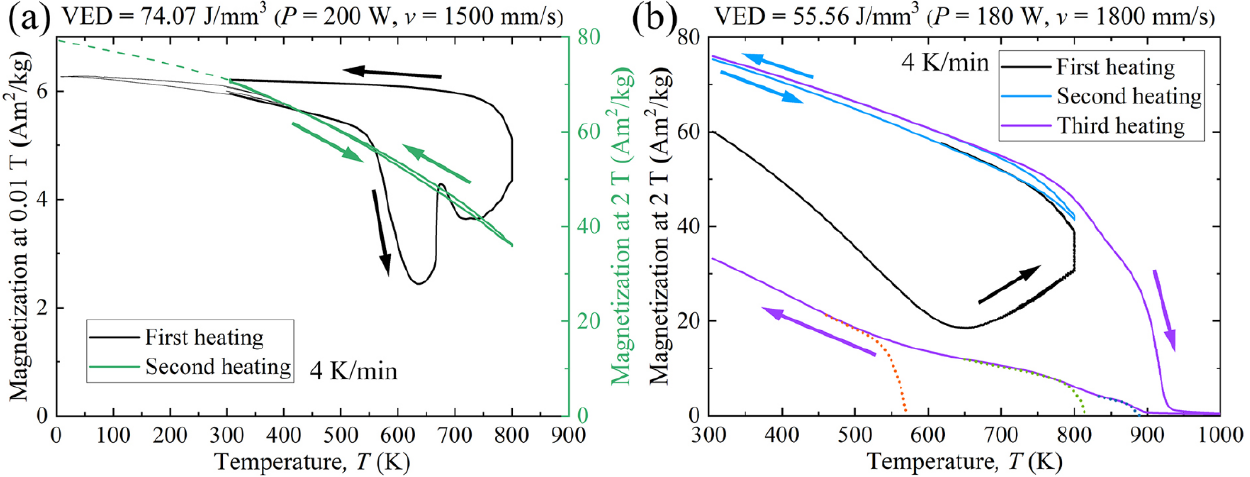
Figure 15. Magnetic behaviors of as-built AlCoCr 0.75 Cu 0.5 FeNi specimens. ( a ) M - T curves in the range of 10 to 800 K and ( b ) M - T curves in the range from 305 to 1000 K.